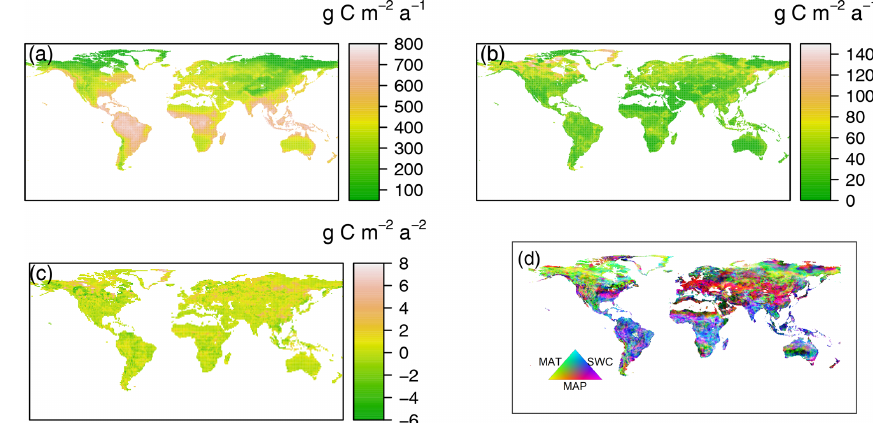
Figure 2. Spatial patterns of (a) mean data-derived RH, (b) standard deviations, (c) temporal trends of annual heterotrophic respiration (RH) from 1980 to 2016 and (d) dominant environmental drivers for the interannual variability of global RH. MAT is mean annual temperature, MAP is mean annual precipitation and SWC is soil water